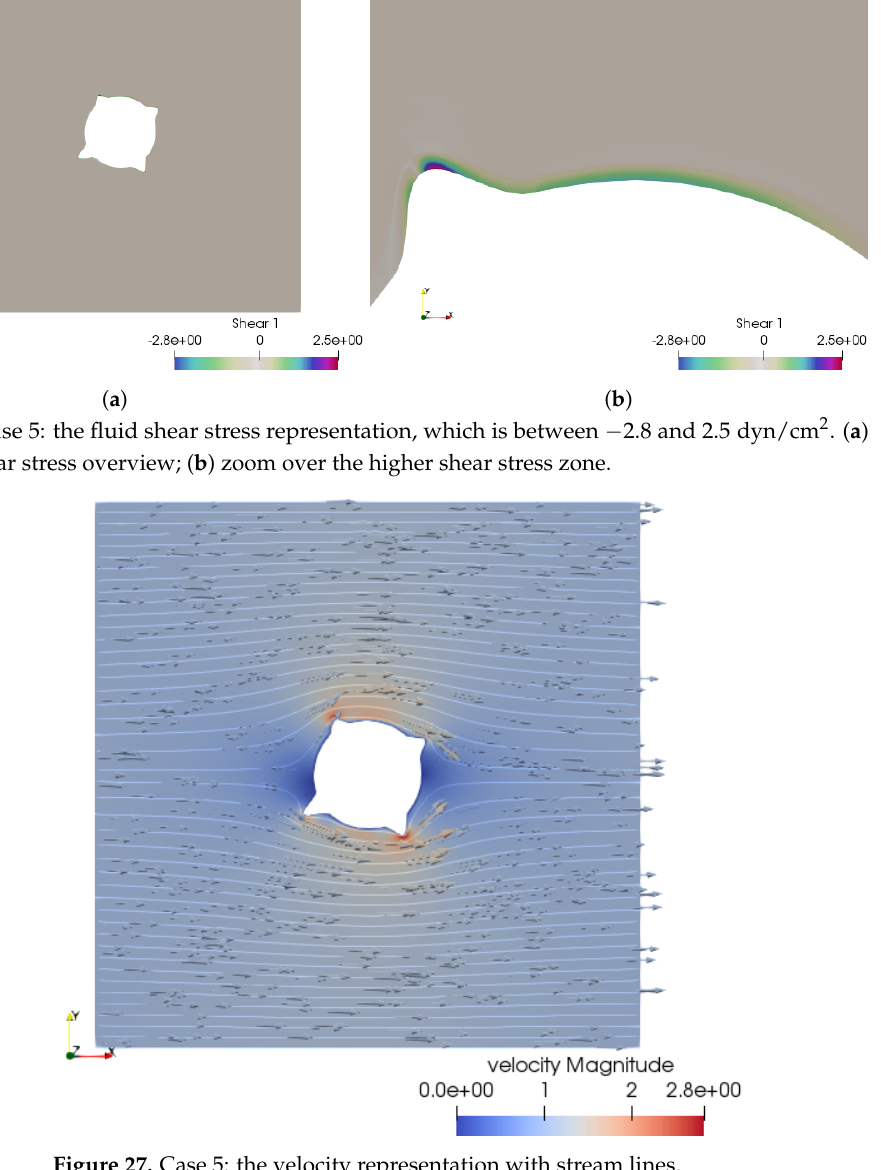
Figure 27. Case 5: the velocity representation with stream